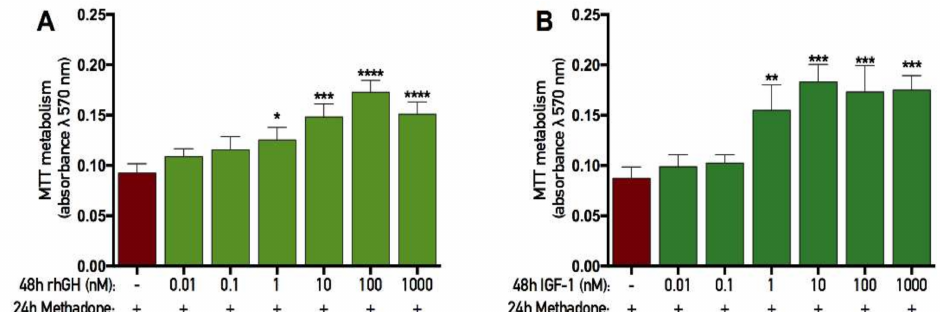
Figure 6. Recovery effects of recombinant human growth hormone and insulin-like growth factor-1 on mitochondrial function following methadone-induced toxicity. Mitochondrial function was assessed by tetrazolium bromide (MTT) assay. Methadone (60 µ M) was added for 24 h and then washed out. The following 48 h, recombinant human growth hormone (rhGH) and insulin-like growth factor-1 (IGF-1) were added for two consecutive days prior to analysis. ( A ) The 48 h recovery effect of rhGH in cells with methadone-induced mitochondrial dysfunction. A significant increase in mitochondrial function was observed using 1, 10, 100, and 1000 nM rhGH. ( B ) The 48 h recovery effect of IGF-1 in cells with methadone-induced mitochondrial dysfunction. A significant increase in mitochondrial function was observed using 1, 10, 100, and 1000 nM IGF-1. Statistics were calculated using two-way analysis of variance (ANOVA) and given a significant overall effect ( p < 0.05), the data were further analyzed using Dunnet’s post hoc test compared to cells exposed to control during the 48 h recovery phase. All data are presented as mean ± SEM in triplicate from five individual cultures. * p < 0.05, ** p < 0.01, *** p < 0.001, **** p <